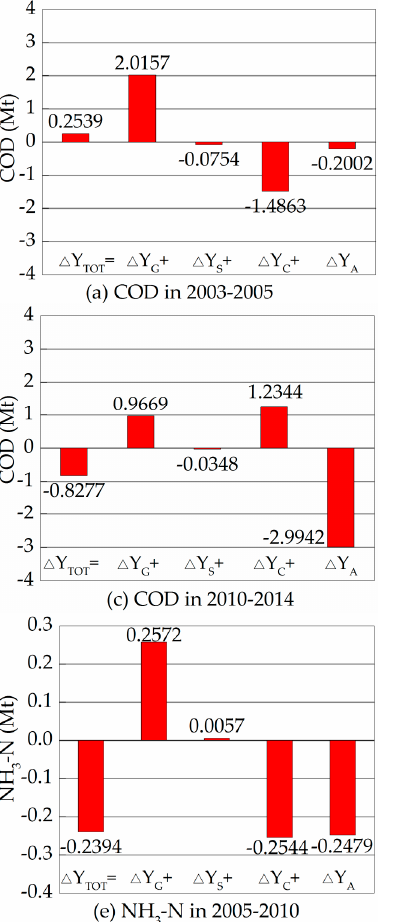
Figure 2. Additive decomposition of the changes in COD and NH 3 -N discharge in China in the three